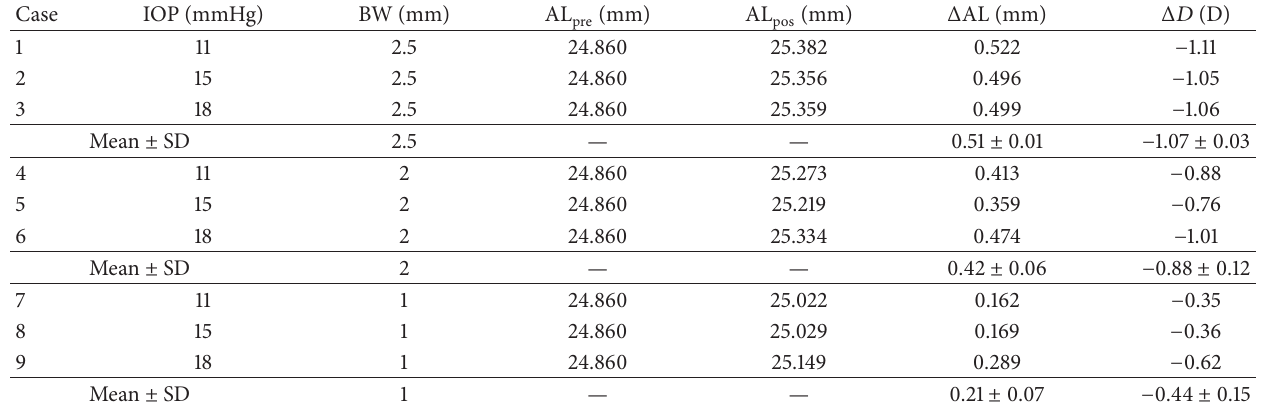
Figure 2: Eyeball before (a) and after (b) encircling scleral buckling surgery. The light-blue bold arrows represent the IOP acting on the inner surface of the eye. 𝑅 𝑖 is the radius of the eyeball at the position where the band is planned to be attached, 𝑢 𝑟 (line arrows) is the radial displacement towards the inner of the eye at the tightening of the band, AL pre is the axial length of the eye before the surgery, 𝑅 𝑓 is the radius of the sclera under the band after the implantation, and AL pos is the postsurgical axial length. Table2:Incrementofmyopia( Δ𝐷 )indiopters(D)inducedbythescleralbucklingsurgeryinthenumericalmodel.Ninecasesareconsidered. IOP is the intraocular pressure, BW is the width of the band implanted, AL pre is the axial length before the simulation of the surgery, AL pos is theaxial length after thesimulation, and Δ AL is theincrement of axial length. Themean value of Δ AL and Δ𝐷 foreach of thethree bandwidths is also